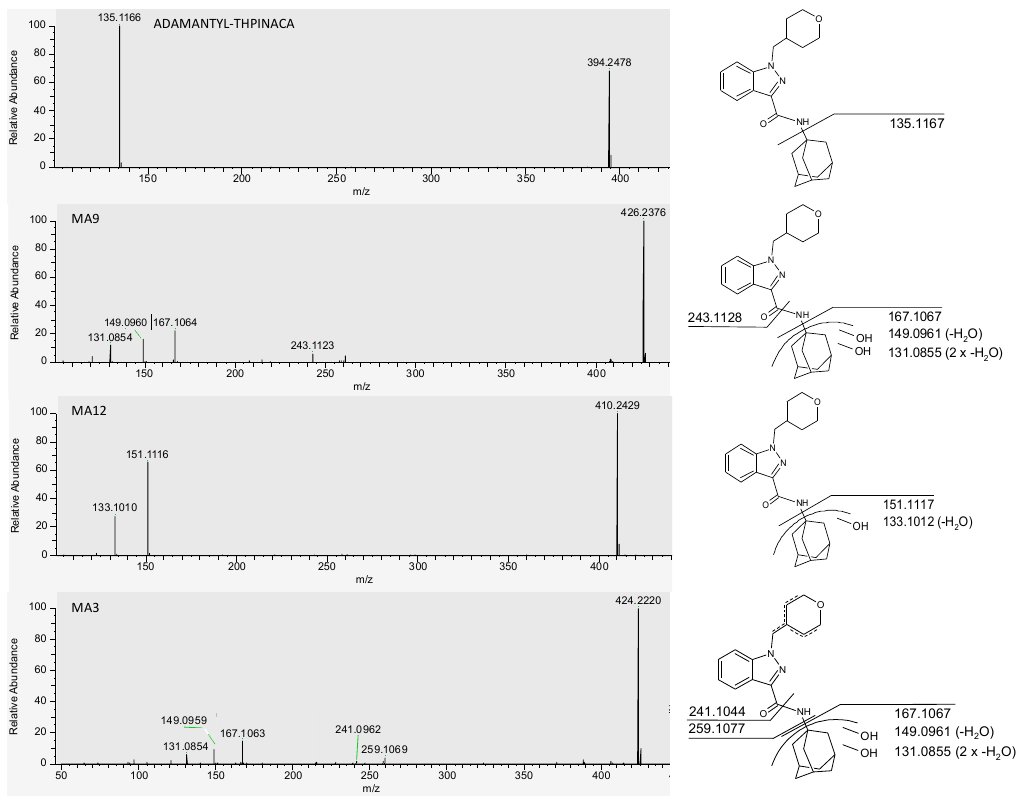
Figure 6. MS2 spectra of ADAMANTYL-THPINACA and its three most abundant metabolites. The proposed fragments leading to the respective signals are shown on the right. Table 3. Summary of all detected metabolites, and observed artefacts thereof, of ADAMANTY-THPINACA (listed in the order of the observed retention times). Shown are the suggested biotransformations, chemical formulas, calculated [M + H] of the parent ions and the corresponding product ions, as well as retention times, area after 2 h of incubation, and rank.